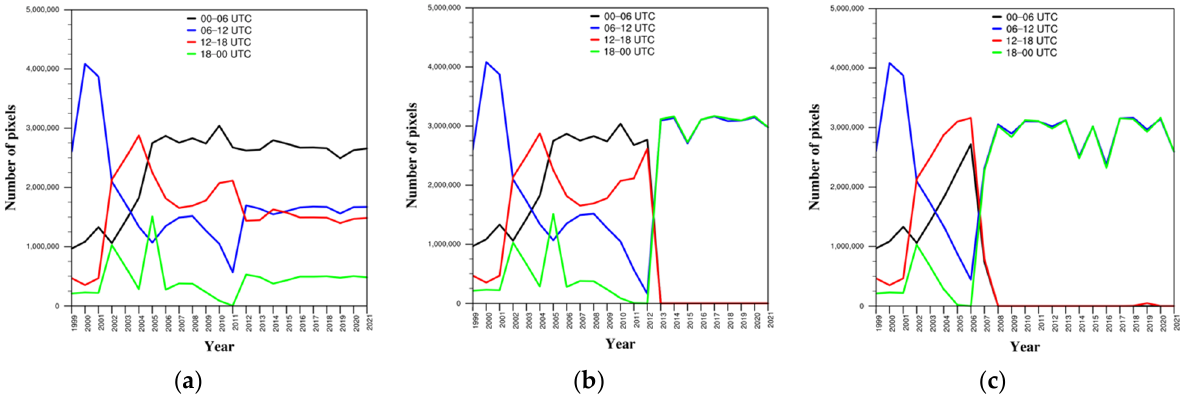
Figure 8. Annual number of pixels processed by the MWCC-H method in the four-time windows. Time series N15-N18-NPP ( a ); time series N15-N18-MOB ( b ); time series N15-MOA-MOC ( c